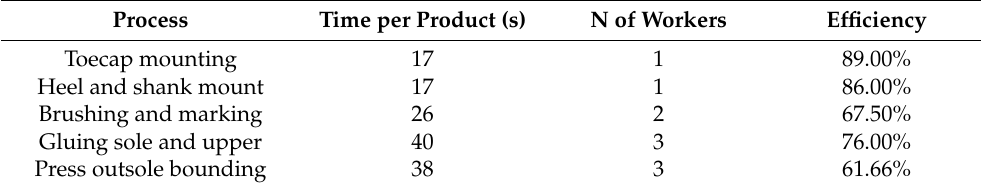
Table 4. Features of optimal sequence for Manufacturer 1 and summary of characteristic operations of the mounting-and-cementing